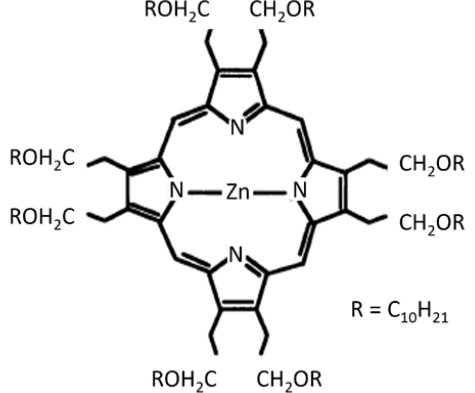
Figure 15. Structure of the photoconductor ZnODEP, after [43], with permission from the American Association for the Advancement of Science.